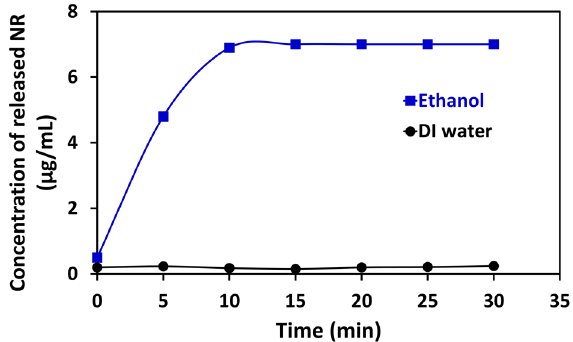
Figure 4. The concentration of released NR in ethanol (blue) compared with DI water (black) at different incubation times.